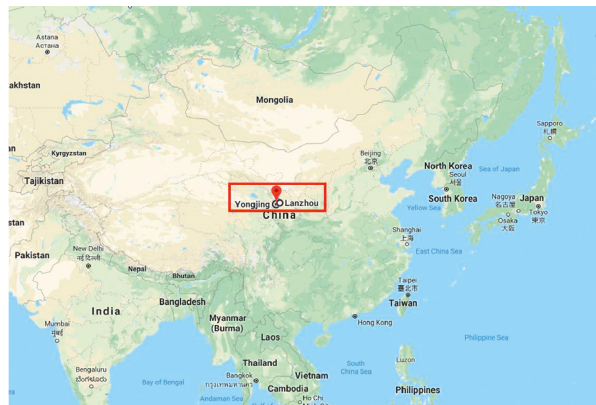
Figure 1: Location of the Lanzhou-Yongjing highway in China (Map Data © 2017 Google).